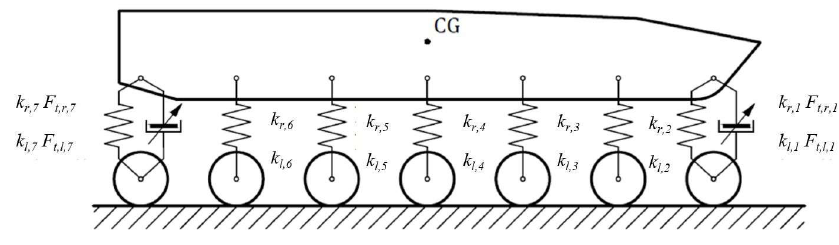
Figure 1. The 2S1 platform suspension model.